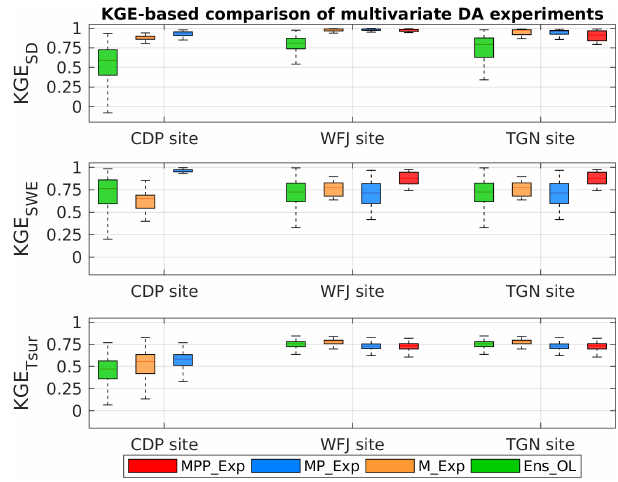
Figure 7. Multivariate DA experiments: multi-year KGE values of snow depth (SD), SWE, and surface temperature ( T sur ) simulations. The Ens OL, M_Exp, MP_Exp (1), and MPP_Exp statistical scores are in green, orange, blue, and magenta, respectively. The bottom and top edges of each box indicate the 25th and 75th percentiles, respectively. The line in the middle of each box is the median. The whiskers extending above and below each box indicate the 5th and 95th